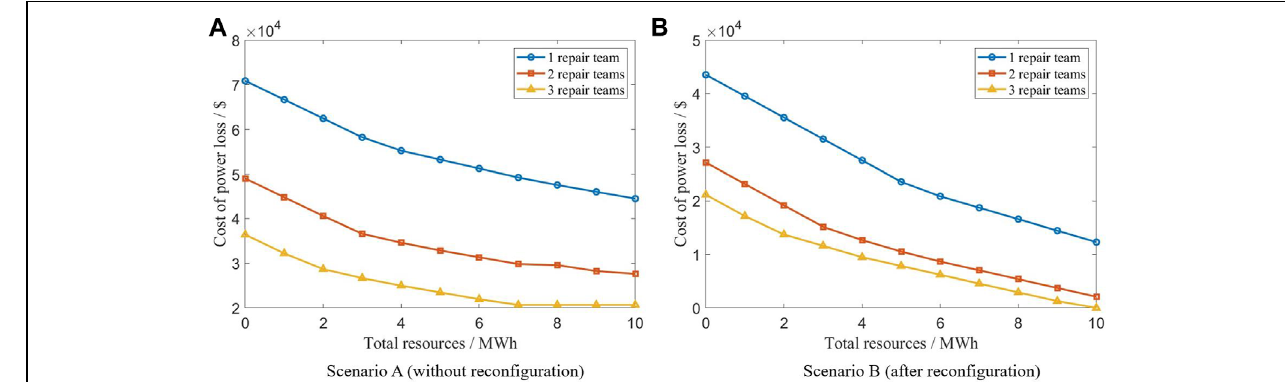
FIGURE 8 | Power loss of scenario (A) and (B) .